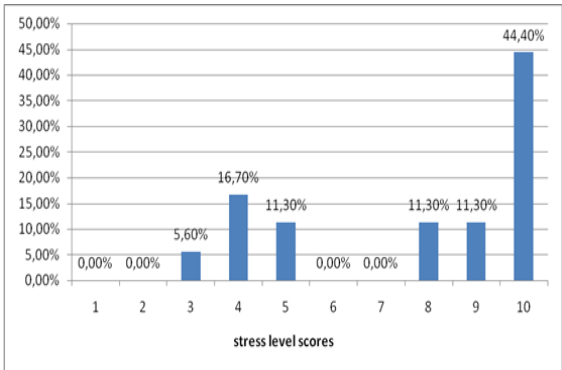
Fig.1. The level of stress caused by the news on husband’s mobilization estimated by the war veterans’ wives